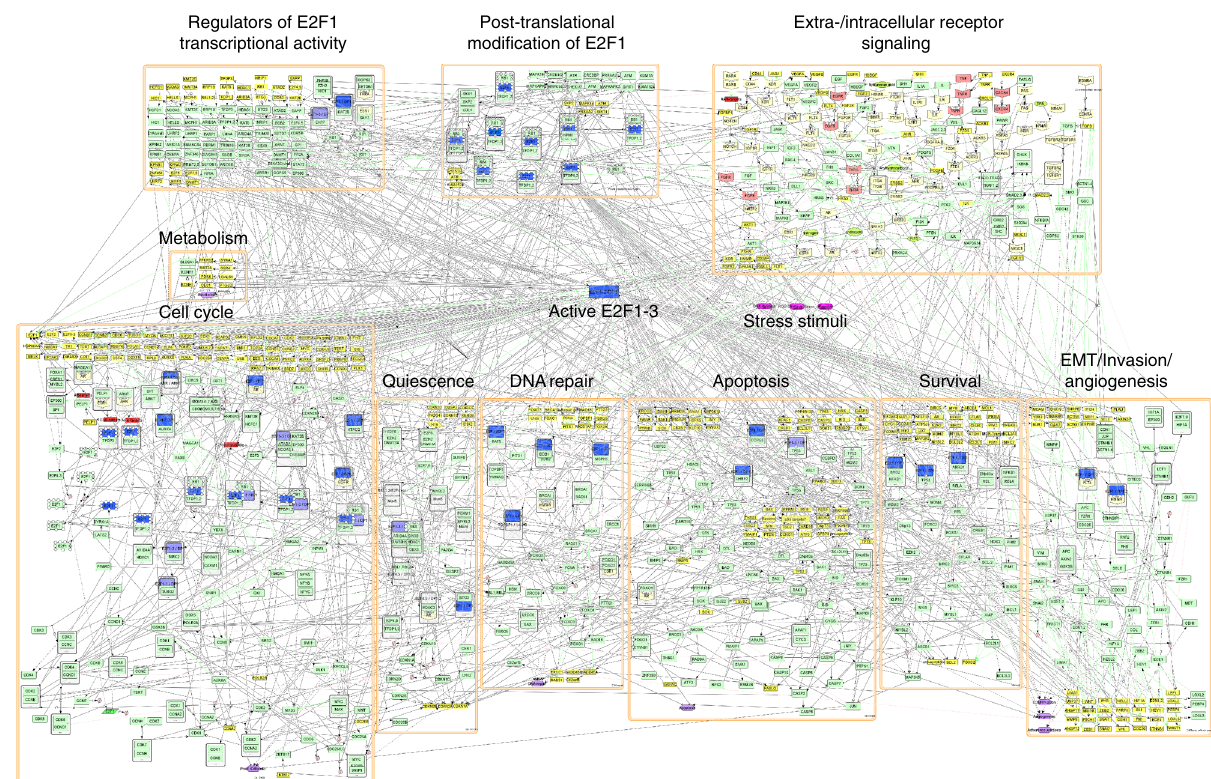
Fig. 1 A modularized map of E2F1 in tumor progression and metastasis. The map contains three E2F1 regulatory compartments: (i) Extra-/intracellular receptor signaling ( n = 113); (ii) Post-translational modi fi cations of E2F1 ( n = 24); (iii) Regulators of E2F1 transcriptional activity ( n = 66). Furthermore, there are seven functional compartments: (i) Cell cycle ( n = 145); (ii) Quiescence ( n = 29); (iii) DNA repair ( n = 33); (iv) Metabolism ( n = 11); (v) Apoptosis ( n = 89); (vi) Survival ( n = 52); (vii) EMT/invasion/angiogenesis ( n = 69), where n stands for the number of factors in each compartment. Biomolecules are visualized in standard CellDesigner format (gene: yellow rectangle ; protein: light green round cornered box ; receptor: light yellow hexagon ; ligand: green oval ; phenotype: violet hexagon ; drug/external stimulus: pink box ). For better visualization, in the map transcription and translation are condensed to one reaction directly leading from gene to protein. In red , we represent place holders for protein families (e.g., FGFR for FGFR1-4, FGF for FGF1-23, ITGA, and ITGB for alpha and beta integrins) and unspeci fi ed genes responding to a given transcription factor. The microRNA layer is not included in this CellDesigner diagram, but in the Cytoscape network provided as Supplementary Information. The interactive E2F1 interaction map can be accessed at: